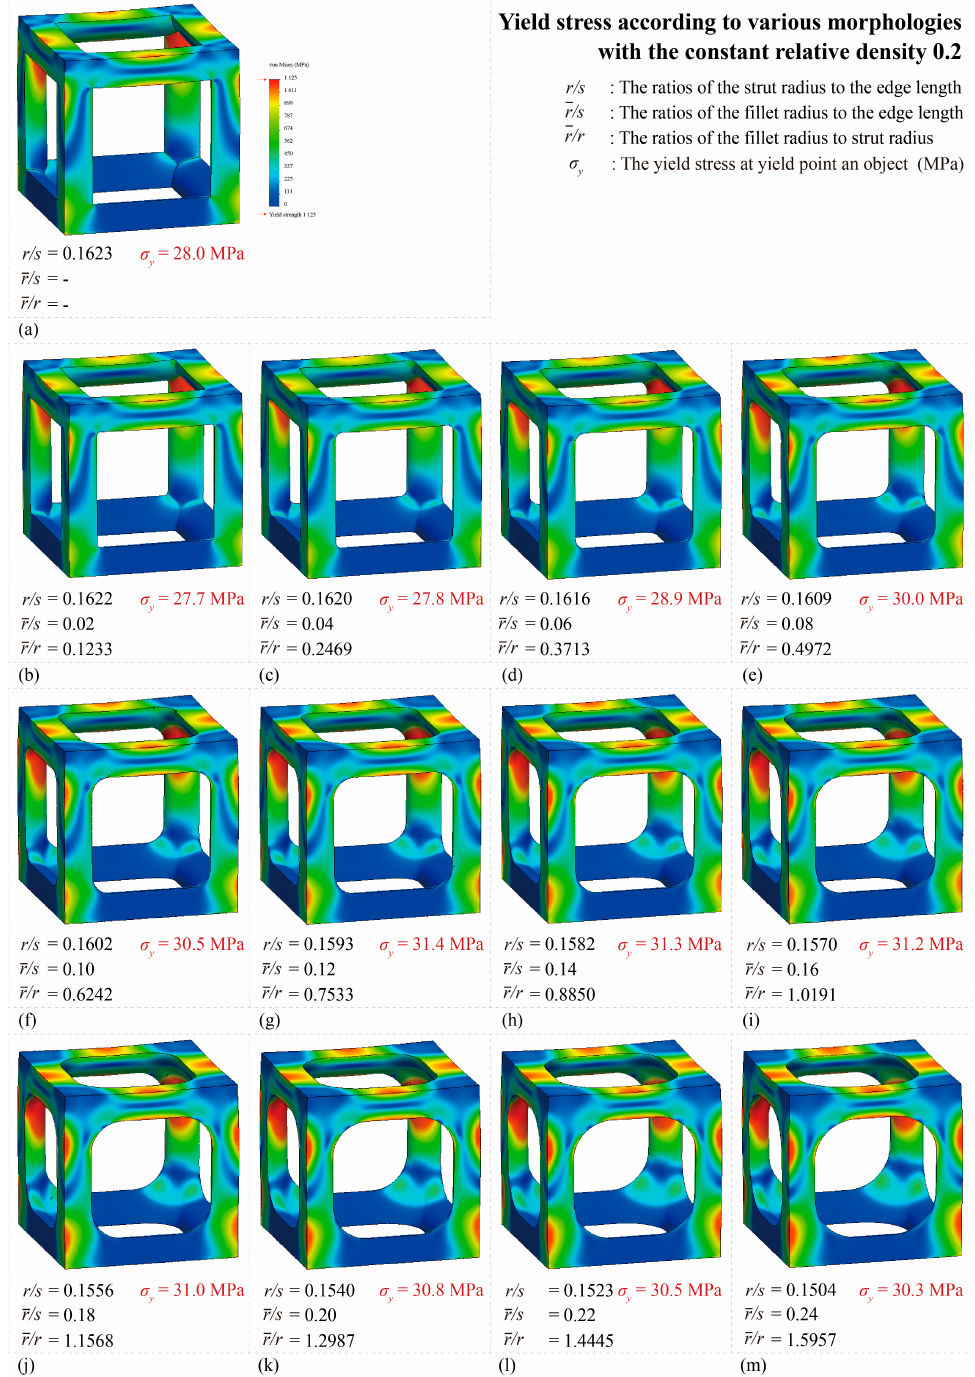
Figure 14. Yield stress according to various fillet edgeless simple cubic unit cells morphologies with a constant relative density of 0.2: ( a ) conventional simple cubic unit cell; ( b – m ) fillet edgeless simple cubic unit cells.